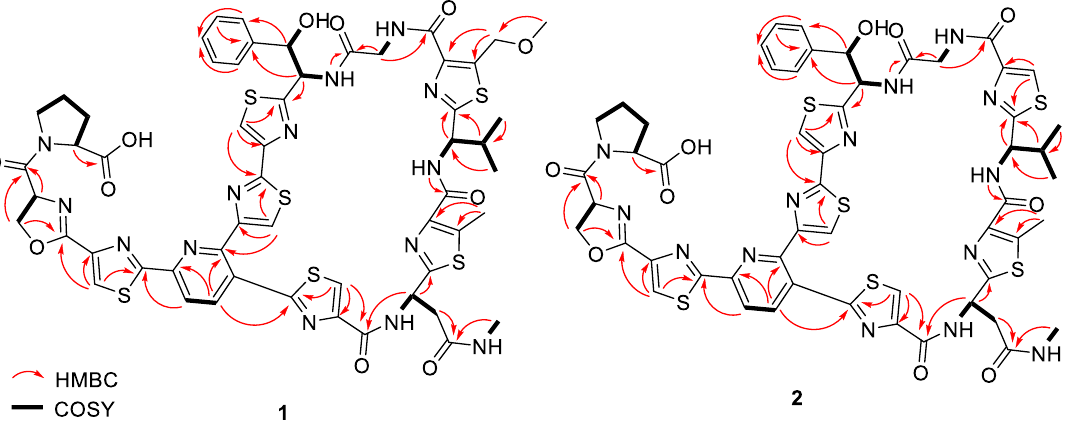
Figure 3. Chemical structures of compounds 1 – 9 .